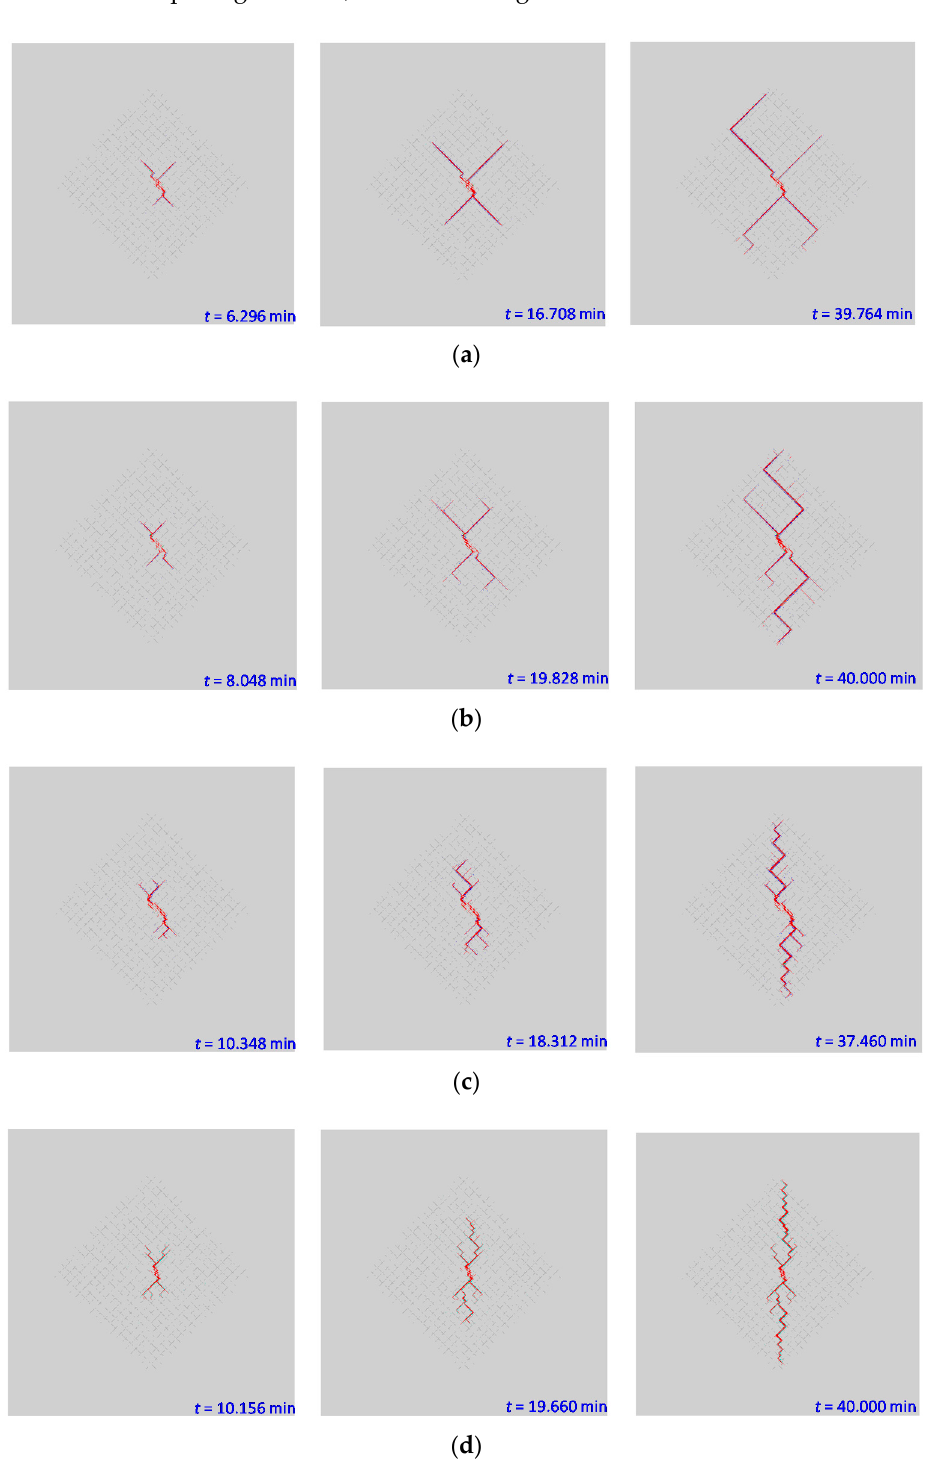
Figure 10. The propagation process of the main hydraulic fractures under different stress